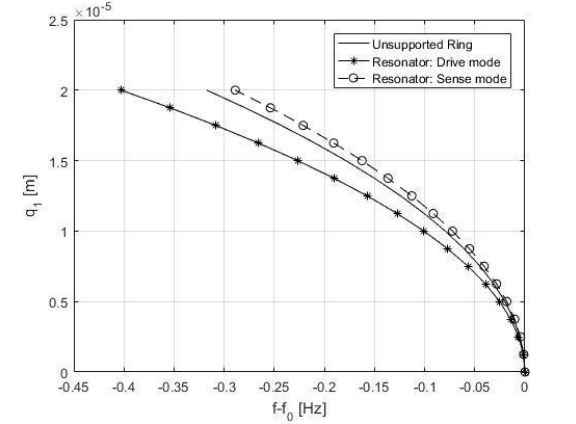
Figure 2. Frequency backbone curves for the 2 (cid:2016) modes for (i) an unsupported ring; (ii) a ring supported by 8 support